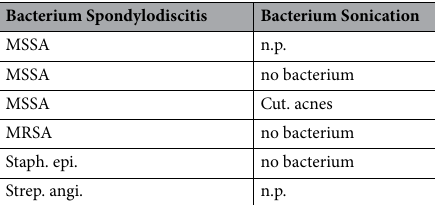
Table 5. Bacteria detected in sonication of explanted CFR-PEEK. Bacteria detected in sonication of CFR- PEEK material which was explanted because of screw loosening. In two cases no sonication was performed. In one case because no revision operation was performed. In the other case because surgery had to be stopped before material explantation because of extreme bleeding. Cut. acnes = Cutibacterium acnes ;